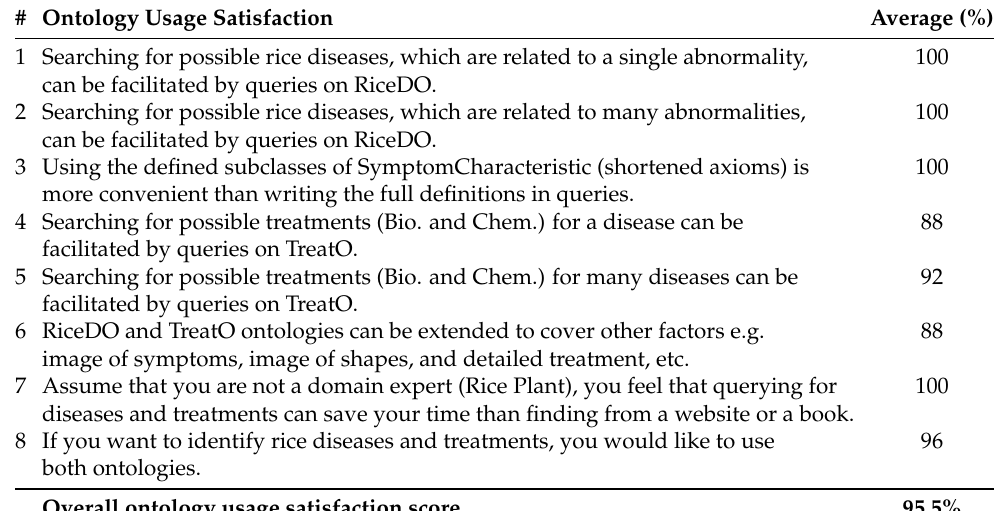
Table A1. Ontology satisfaction from the ontology specialists’ perspective.